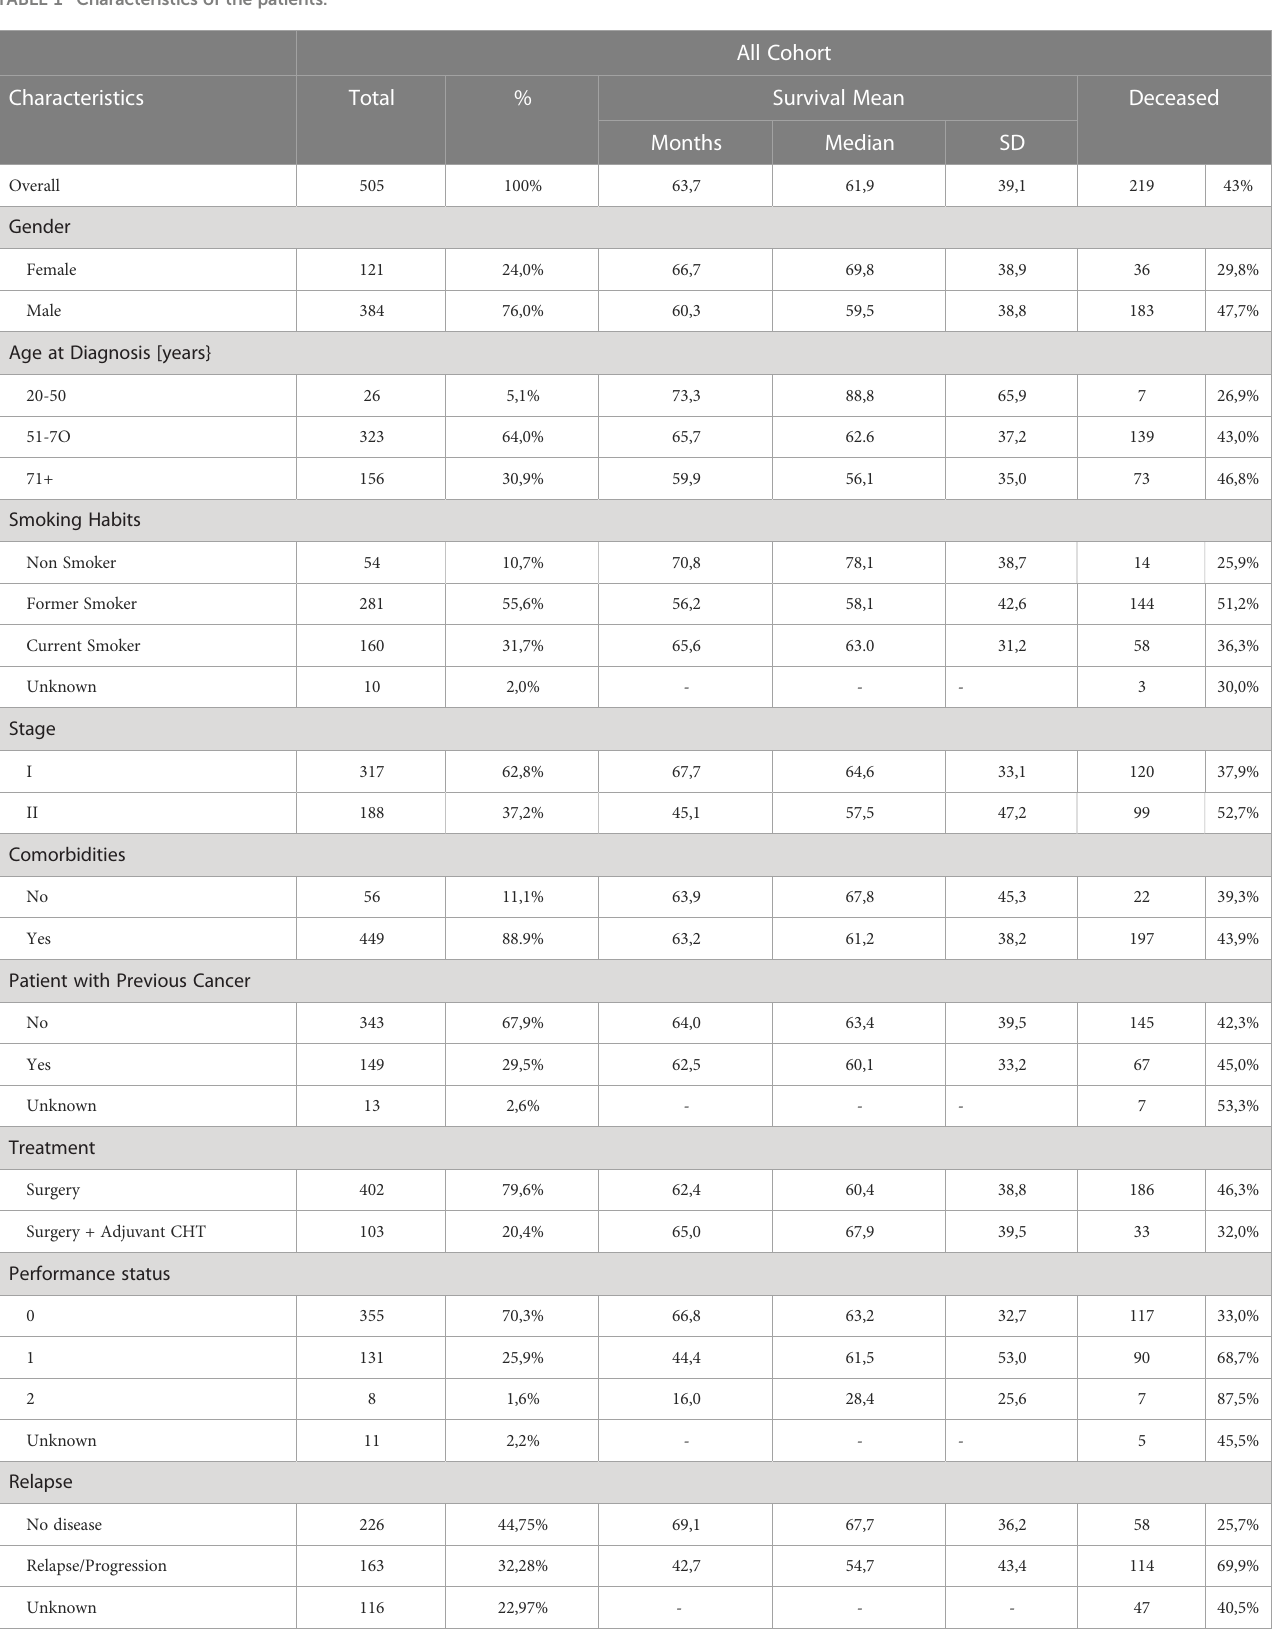
TABLE 1 Characteristics of the patients.